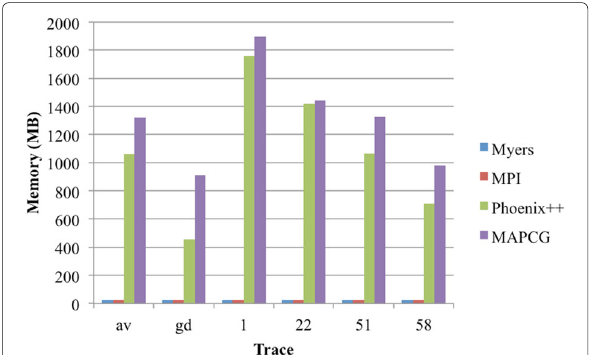
Myers algorithm. MAPCG achieves the best speedup of all implementations. The speedup was more than four times for the normal (gd) network traffic trace. The (gd) trace is the largest dataset that was used in the evaluation. This is because a large data size allows the MapReduce run- time to better utilize its underlying design and remove the overheads of buffer allocation and task management. data analytics.